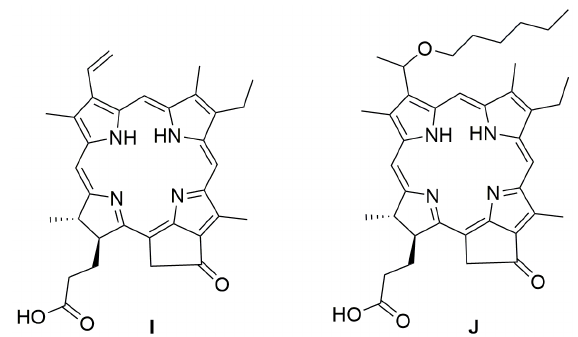
Figure 10 - Structure of pyropheophorbide a ( I ) and Photochlor ( J